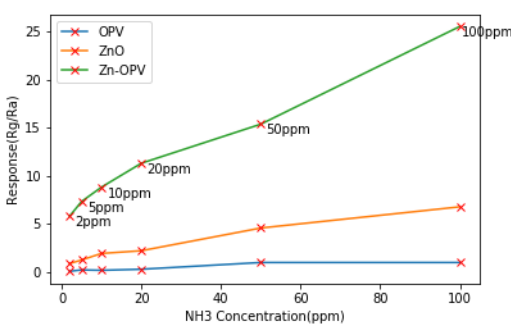
Figure 4. The Performance of Zn-OPV for Detecting NH 3 at Room Temperature